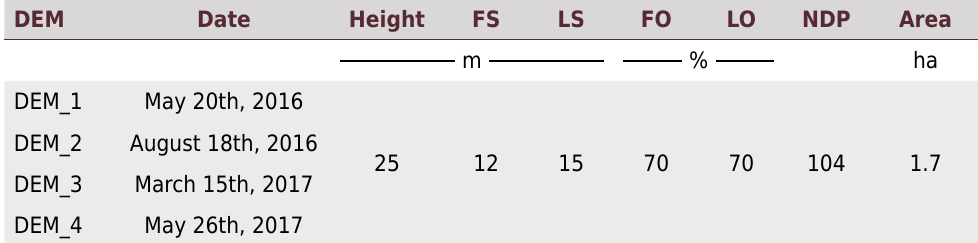
Table 2. Geomorphic change detection points cloud density, error of image alignment accuracy, and spatial resolution of the digital elevation model DEM PCD